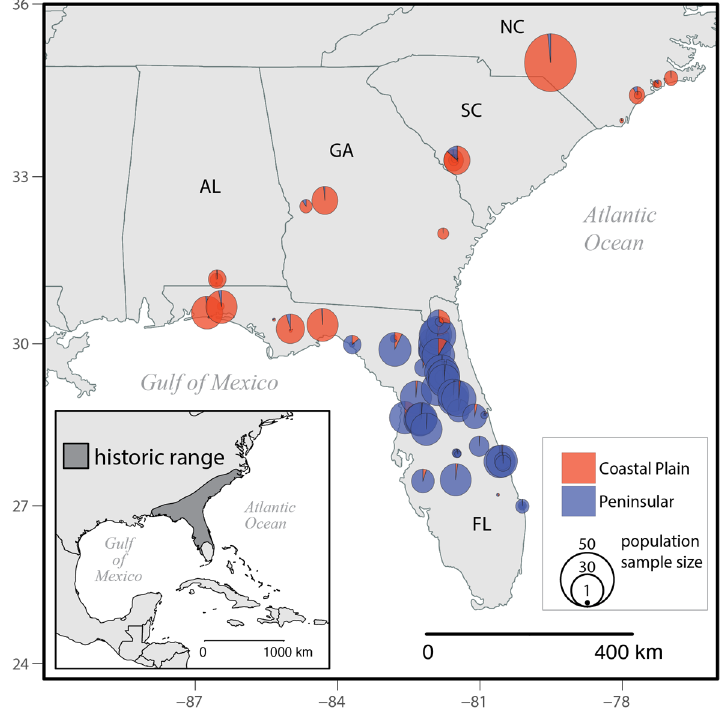
Figure 3. Results from structure analysis of the entire dataset assuming admixture with correlated allele frequencies among populations and using location information as a prior. At K = 2, Coastal Plain and peninsular Florida populations formed separate clusters.